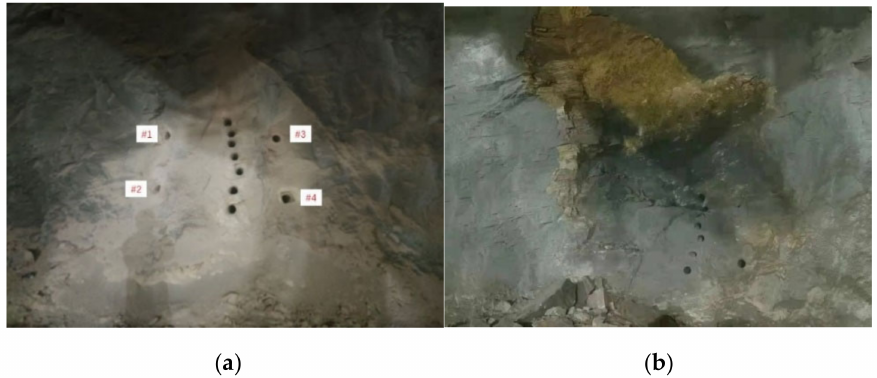
Figure 8. The comparison before and after cutting rock mass cracking in test 1. ( a ) Tunnel face before cutting rock mass cracking; ( b ) Tunnel face atter cutting rock mass cracking.